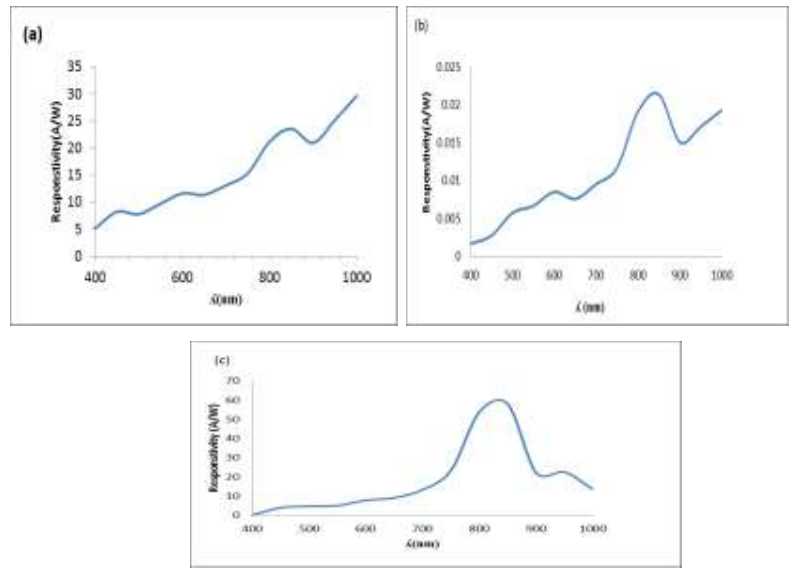
Figure 6: Responsivity of C-Si, and PS specimen at varied etching time(a) 5, (b) 15 and (c) 25, min., etching current density 20 mA/cm² at HF concentration